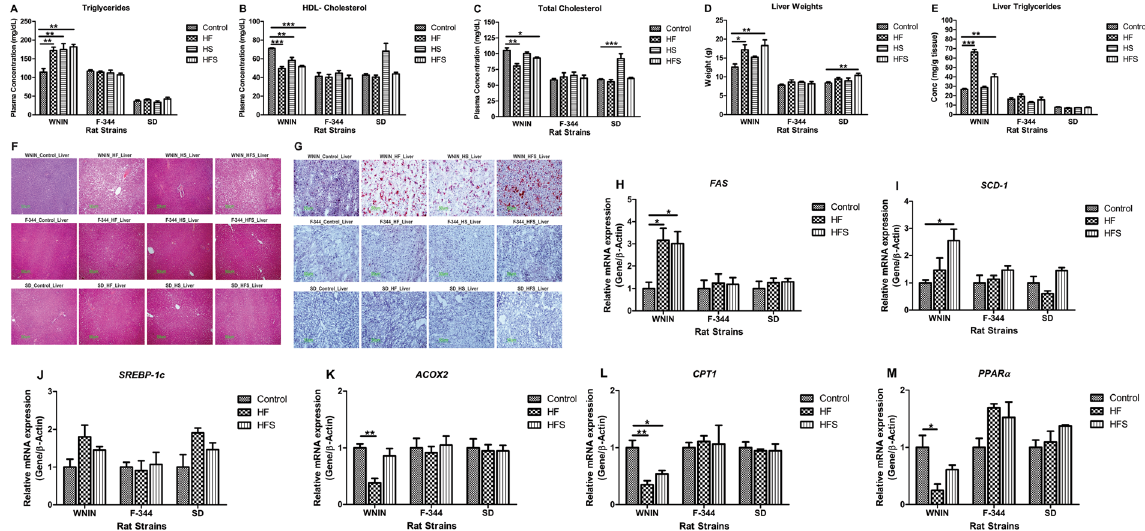
Figure 5. Effect of high calorie environment on lipid metabolism: Lipid profile, lipogenesis and beta oxidation in genetically different rat strains. Fasting plasma was used to estimate the concentrations of ( A ) Triglycerides. ( B ) HDL- Cholesterol. ( C ) Total - cholesterol. ( D ) Dissection weights of liver. ( E ) Liver triglycerides levels were measured to determine the fatty liver condition. ( F & G ) Hematoxylin-Eosin (H&E) stain and Oil Red O stain were performed on liver sections to assess hepatic lipid droplet storage. Relative mRNA expression of ( H ) Fatty acid synthase (FAS), ( I ) Stearoyl-CoA desaturase-1 (SCD-1), ( J ) Sterol regulatory element-binding protein 1-c (SREBP-1c), ( K ) Acyl-CoA Oxidase 2 (ACOX2), ( L ) Carnitine palmitoyltransferase 1 (CPT1), and ( M ) Peroxisome proliferator-activated receptor α (PPAR α ) to understand the regulation of hepatic lipogenesis and beta oxidation. Data was presented as mean ± SEM (n = 6 per group). Diets: control; HF, high fat; HS, high sucrose; HFS, high fat sucrose. * P < 0.05; ** P < 0.01; *** P < 0.001 statistically significance compared to their